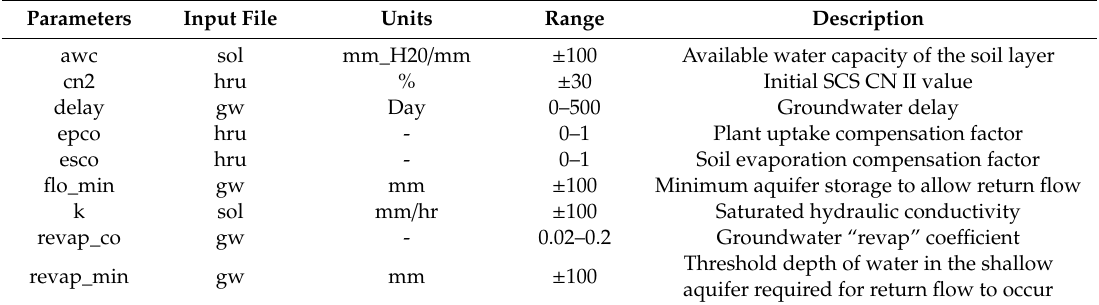
Table 2. Descriptions of SWAT + parameters selected for calibration in case